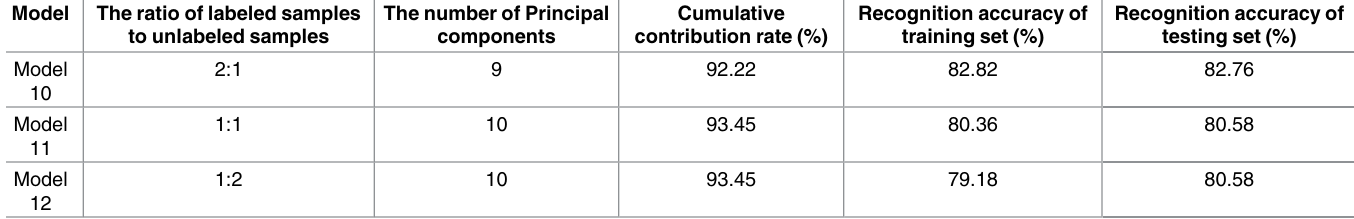
Table 8. Recognition results of four alfalfa leaf diseasesusing optimal semi-supervised models with various ratios of labeled to unlabeled samples. Model The ratio of labeled samples to unlabeled